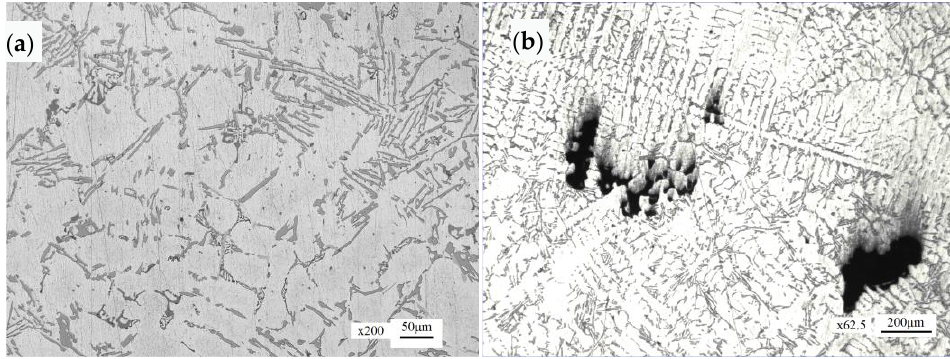
Figure 14. Microstructure morphology: ( a ) manhole cover matrix, ( b ) porous casting defects.